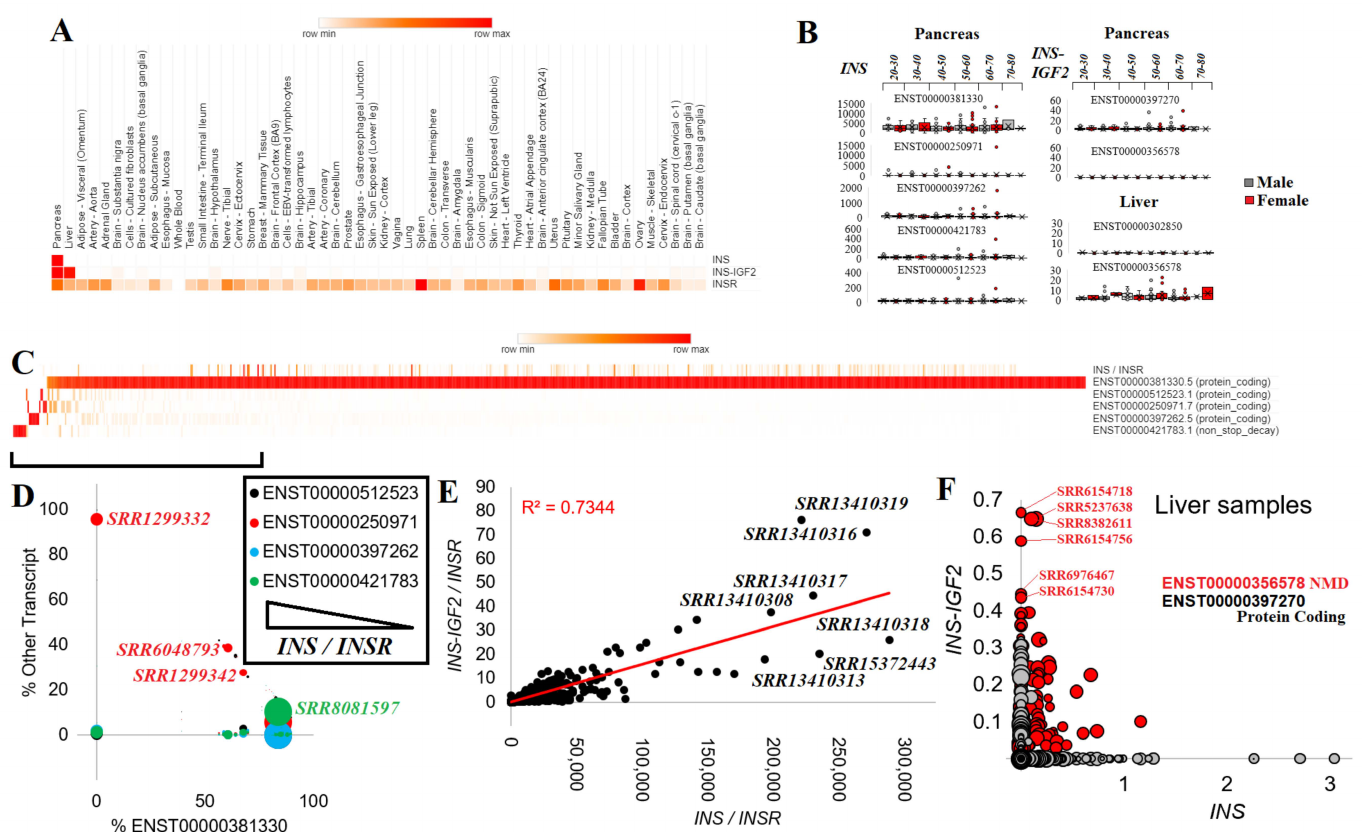
Figure 4. Expression of Insulin ( INS ) in public datasets. ( A ) GTEx average expression of INS , INS–IGF2 , and INSR over various tissues. The heat map shows the max expression of each gene in red. ( B ) Box and whisker plots for the various INS (left) or INS–IGF2 (right) transcripts in the pancreas and liver relative to each age group of samples. Male samples are shown in gray, and female samples are shown in red. ( C ) Heat map of INS / INSR ratio and each of the five transcripts of INS for 1360 “Pancreas”, “Islets”, or “Langerhans” human RNAseq samples. Values for INS represent the percent of total INS levels for each transcript. ( D ) Individual sample breakdown from Panel C for those with <90% of the transcript abundance for ENST00000381330 (x-axis) shown relative to the other transcripts. The size of the bubble represents the total INS/INSR levels. ( E ) Normalized values for INS (x-axis) and INS–IGF2 (y-axis) relative to INSR for various pancreas RNAseq BioProjects. The red line is the best-fit trendline with the R 2 shown. ( F ) The expression of INS and INS - IFG2 in transcripts per million from 1901 “liver” or “hepatocyte” human RNAseq samples. The red transcripts are those of INS–IGF2 ENST00000356578. The size of the bubble represents the expression of Albumin ( ALB ), a marker of